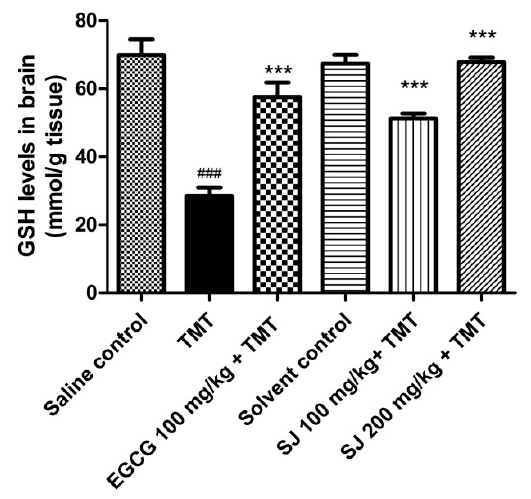
Figure 8. GSH brain levels in mice pretreated with SJ extract, at two di ff erent doses, then injected TMT. SJ 200 mg / kg group showed highly significant increase in GSH levels in comparison with TMT treated group. Statistical analysis was performed via one-way ANOVA then Bonferroni’s method. *** p < 0.001 in comparison with TMT group and ### p < 0.001 in comparison with saline control group.